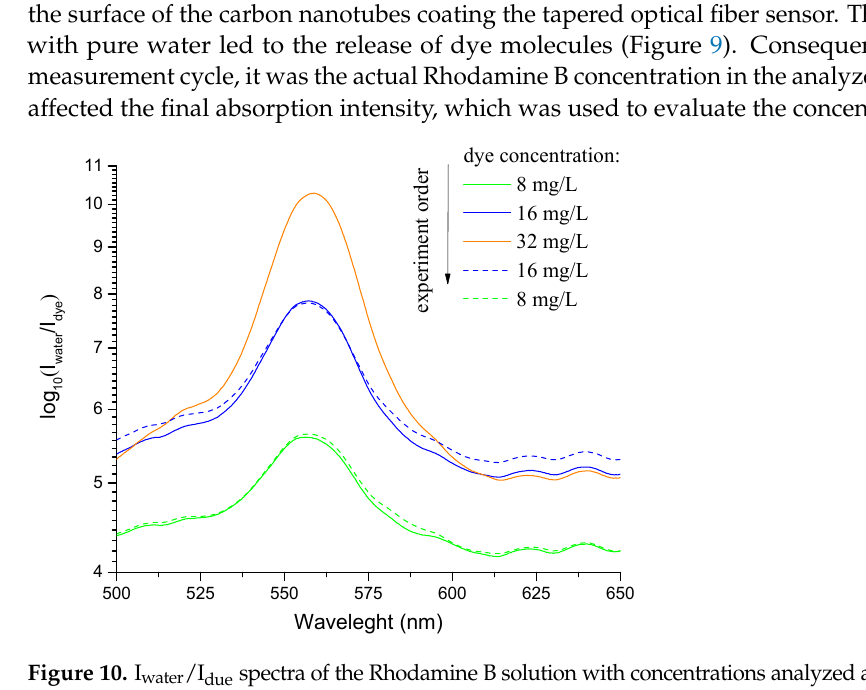
Figure 10. I water /I due spectra of the Rhodamine B solution with concentrations analyzed as follows: 8, 16, 32, 16, and 8 mg/L (solid lines, increasing dye concentration; dashed lines, decreasing dye concentration).